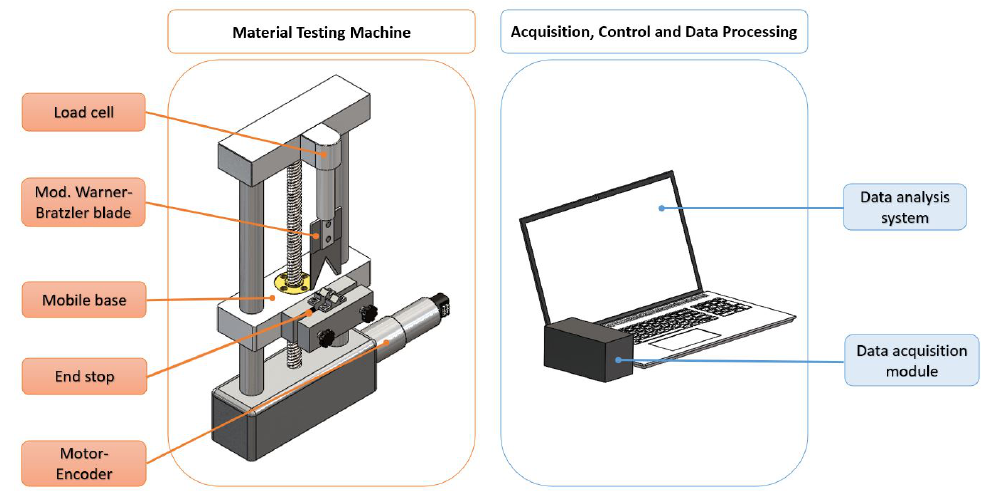
Figure 2. Diagram of the shear test devices.